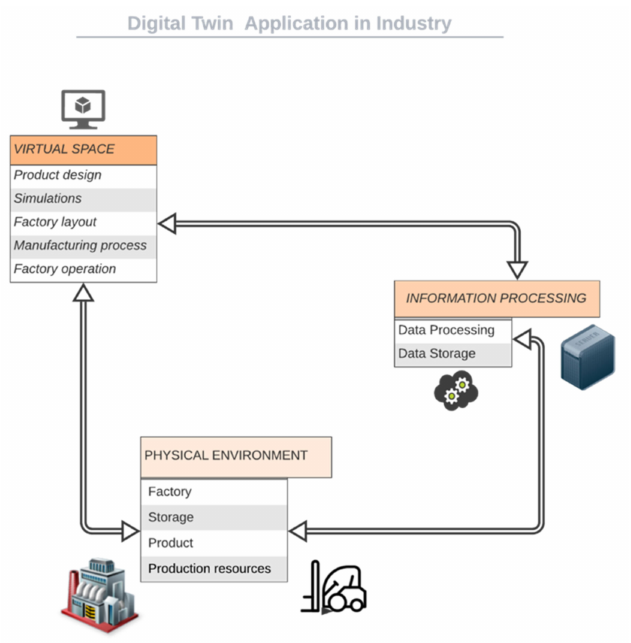
Figure 1. An example of the application of digital twin in